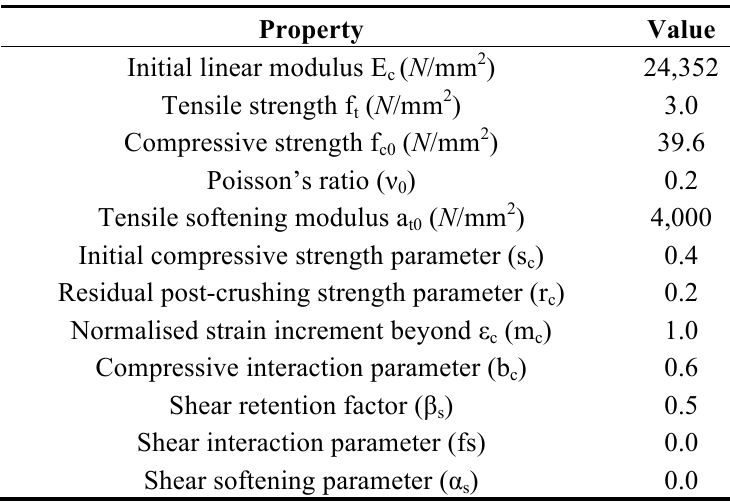
Table 2. Concrete material properties